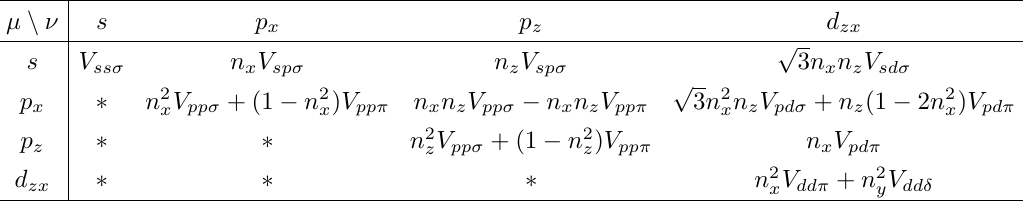
Table 1 . Table of off-diagonal elements of T ij